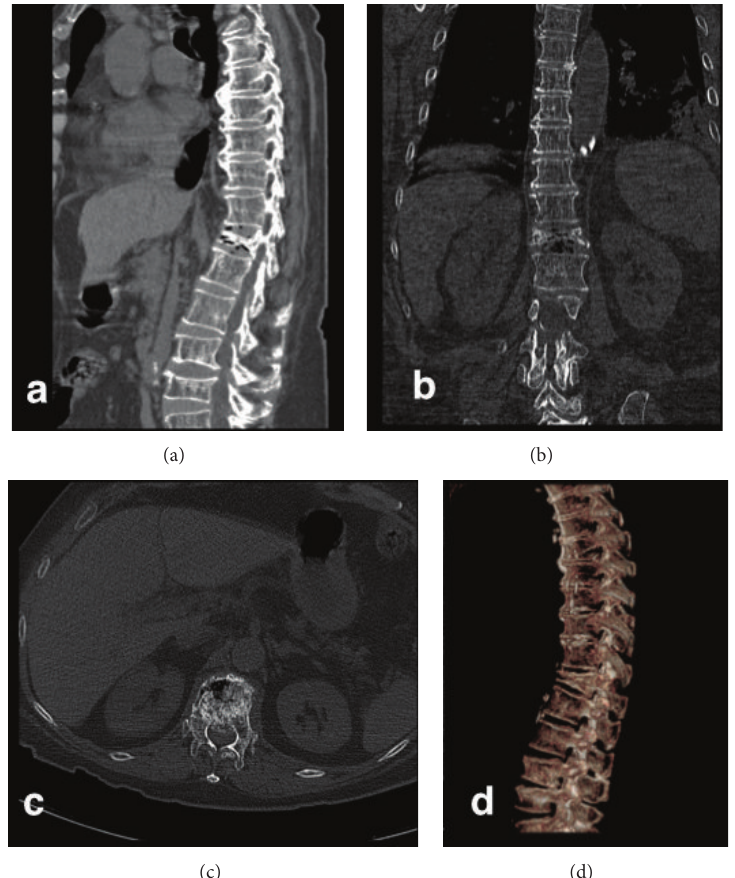
Figure 1: Computed tomography of thoracic spine in (a) sagittal, (b) coronal, and (c) axial projections revealed a T10 vertebral osteoporotic compression fracture and generalized spondylosis of thoracic and lumbar spine. Normal thoracic curvature was affected. (d) 3-dimensional images revealed in detail the wedge-shaped thoracic vertebrae and degenerative